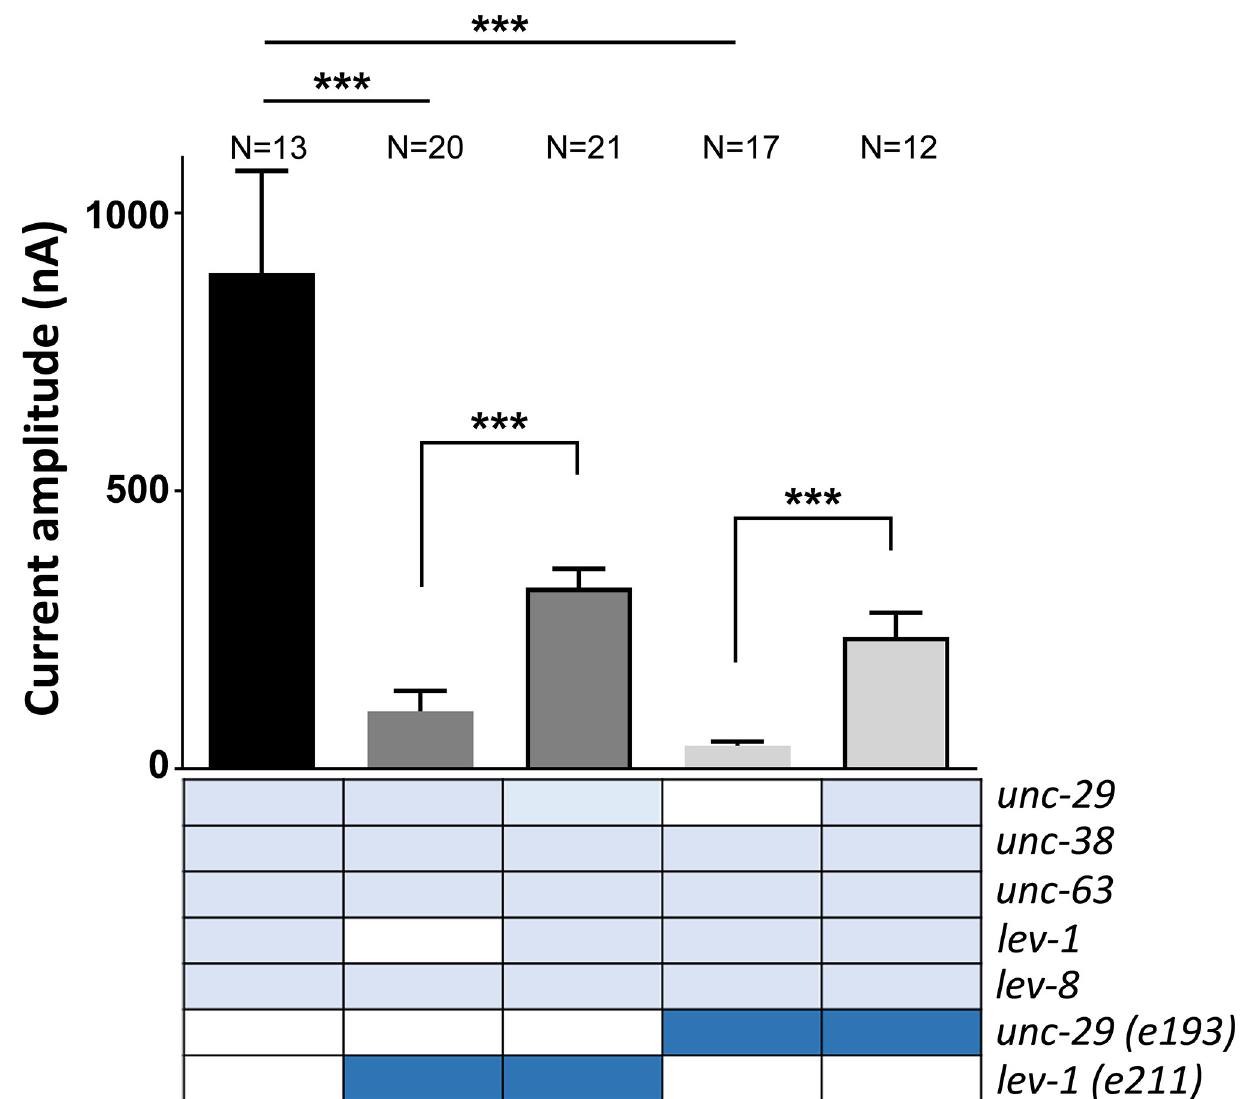
Fig 9. The mutant genes in lev-1 (e211) and unc-29 (e193) encode for subunits that assemble L-type receptors with reduced function. Current amplitude to 300 μ M of acetylcholine was quantified in different populations of L-type receptors in Xenopus oocytes expressed from cRNA encoding either wild type, lev-1 (e211) or unc-29 (e193) mutations (dark blue). The substitution of the cRNA for wild type lev-1 or unc-29 subunits for their respective lev-1 (e211) or unc-29 (e193) mutations reduced the current amplitude of the L-type receptor. The co-expression of wild type and mutant genes in a 1:1 ratio causes a reduction of the amplitude to acetylcholine-evoked currents, indicating both subunits compete for inclusion into the mature ion channel. Data are shown as the mean ± SEM. Numbers above bars indicate the number of oocytes recorded for each condition. Statistical significance was calculated by two-tail t-test. *** p �